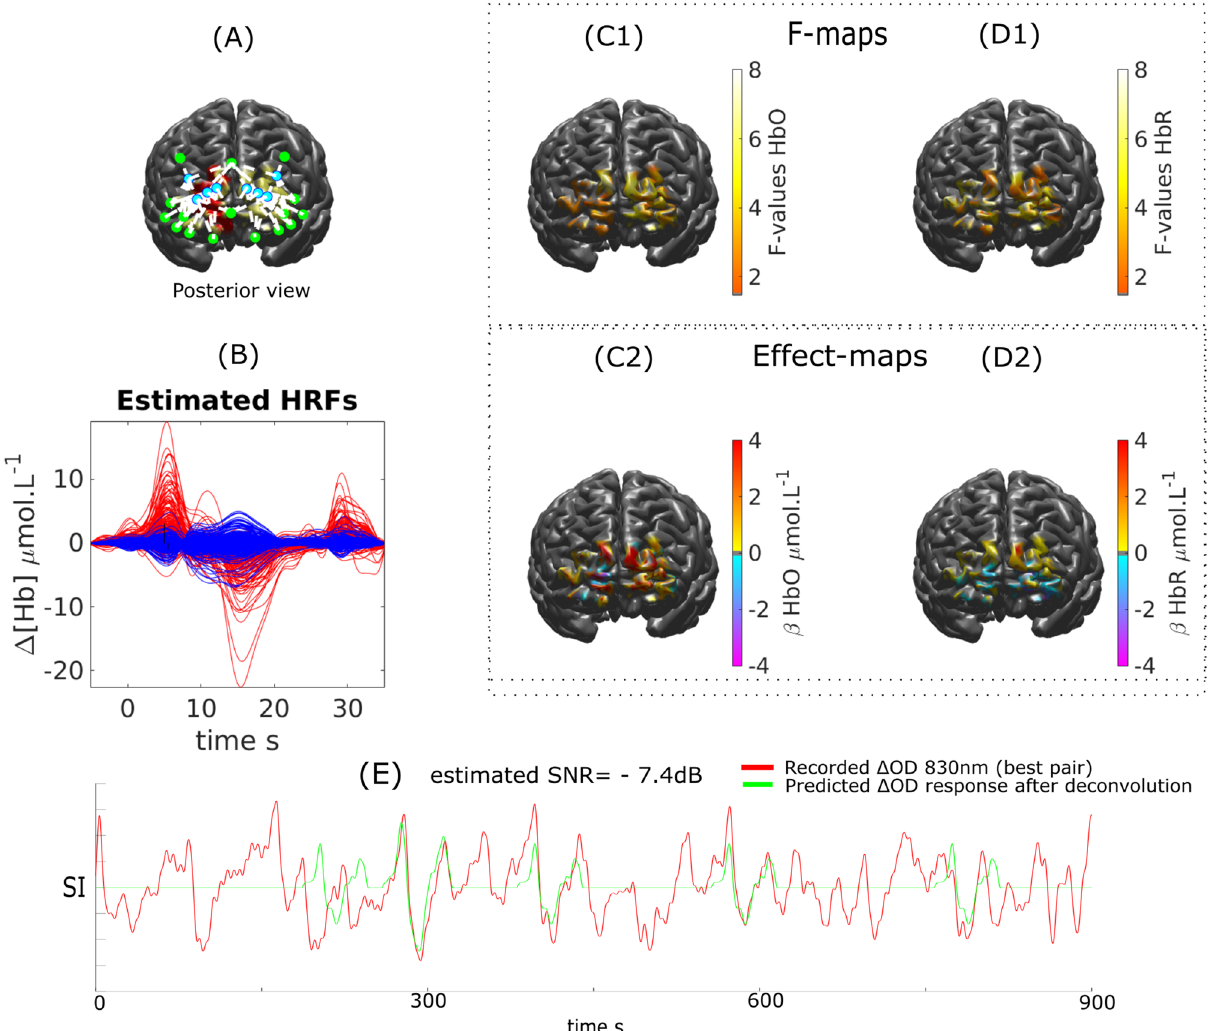
Figure 12. EEG/fNIRS investigation of a patients with right frontal epilepsy. DOT reconstruction and HRF deconvolution for HbO and HbR response following bursts of rapid activity. ( A ) Montage, ROI (red) and FOV (yellow). ( B ) Estimated HRF time courses. ( C1 , C2 ) (cid:31) [ HbO ] : Thresholded F-map ( α = 0.05 , Bonferronni corrected) and associated effect size map estimated at TTP 1 = 5 s. D1,D2) (cid:31) [ HbR ] : Thresholded F-map ( α = 0.05 , Bonferronni corrected) and associated effect size map estimated at TTP 1 = 6 s. ( E ) Most sensitive (cid:31) OD 830 pair over the target ROI and corresponding predicted response after deconvolution (at the sensor level) with the binary stimuli vector representing transient epileptic